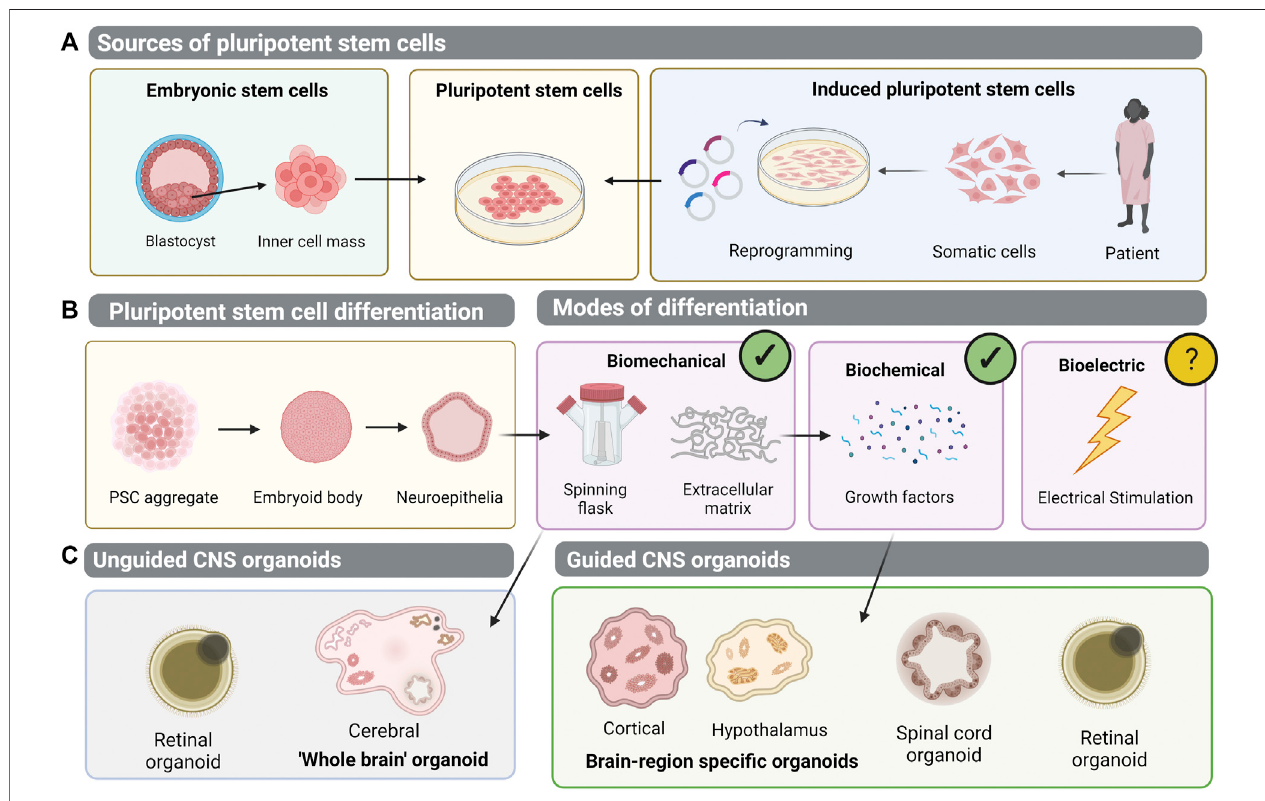
FIGURE 1 | Generation of pluripotent stem cell-derived organoid models of the central nervous system (CNS). (A) Human pluripotent stem cells (hPSCs) can be isolated from the inner cell mass of an embryo- embryonic stem cells (ESCs). Alternatively, patient-dervied somatic cells can be reprogrammed to induced pluripotent stem cells (iPSCs). (B) Pluripotent stem cells can be differentiated into 3D aggregates which form embryoid bodies and neuroepithelial vesicles. Biomechanical and biochemical differentiation cues have been implemented to generate 3D organoid structures, but bioelectric cues of differentiation remain unexplored. (C) In unguided CNS organoid protocols, differentiation relies on the intrinsic self-organisation properties of PSCs, to generate cerebral brain organoids or retinal organoids. Meanwhile, guided protocols employ exogenous growth factors to generate brain-region speci fi c organoids, spinal cord organoids, or retinal organoids.